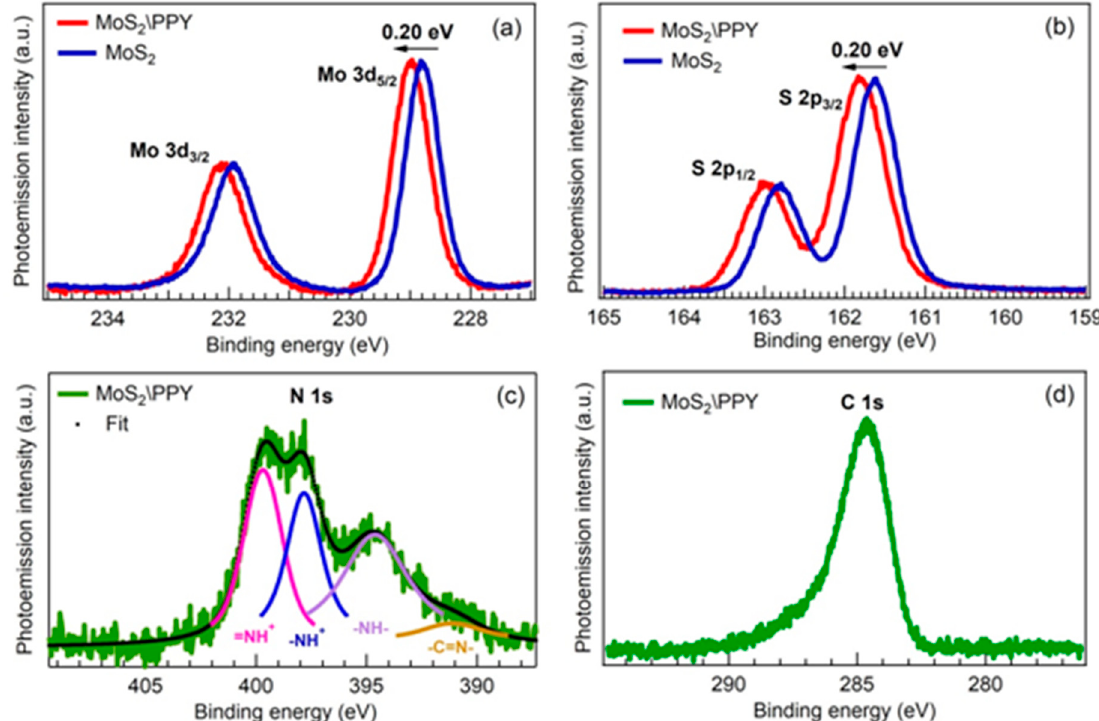
Figure 2. High-resolution XPS core-level spectra of ( a ) Mo3d, ( b ) S2p, ( c ) N1s, and ( d ) C1s measured on MoS2 nanosheets and on MoS2/PPyNPs.